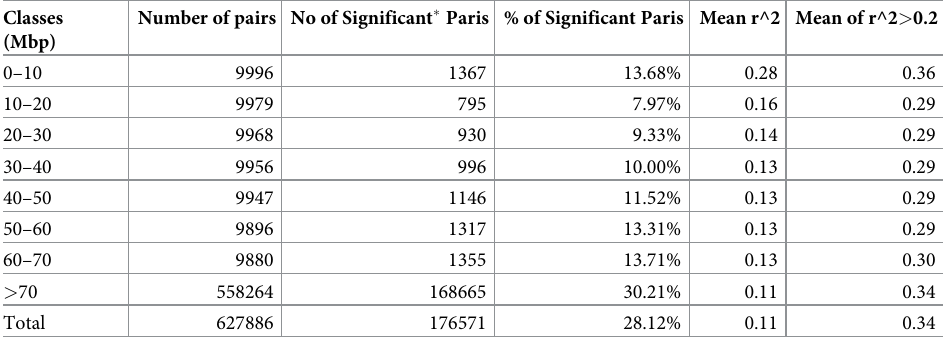
Table 5. Linkage disequilibrium estimate among Ethiopian durum wheat panel. Classes (Mbp)